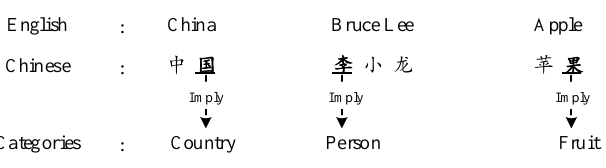
Figure 1. Information implied by Chinese